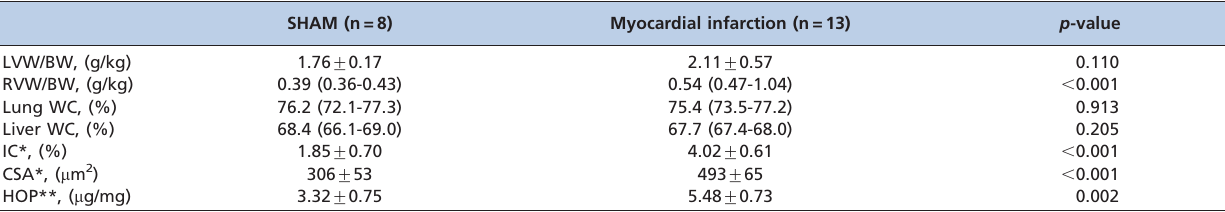
* 7 rats per group; ** 5 rats per group. SHAM: rats subjected to surgery but without coronary occlusion; BW: body weight; LVW: left ventricular weight; RVW: right ventricular weight; WC: water content; IC: interstitial collagen volume fraction; CSA: myocyte cross-sectional area; HOP: hydroxyproline. Data are expressed as means ¡ SD or medians